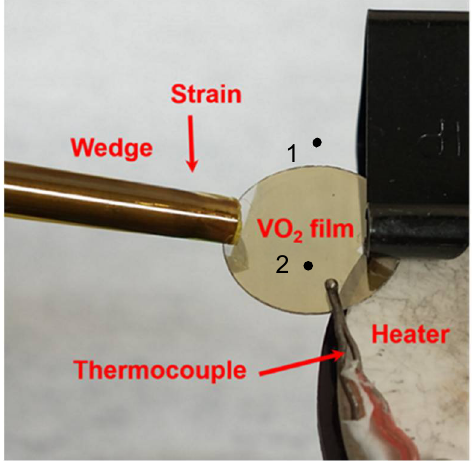
Figure 2. The experimental setup for application of mechanical strain applied on VO 2 thin film syn- thesized on muscovite substrate. Points 1 and 2 indicate the electrical contact points for resistance measurement.